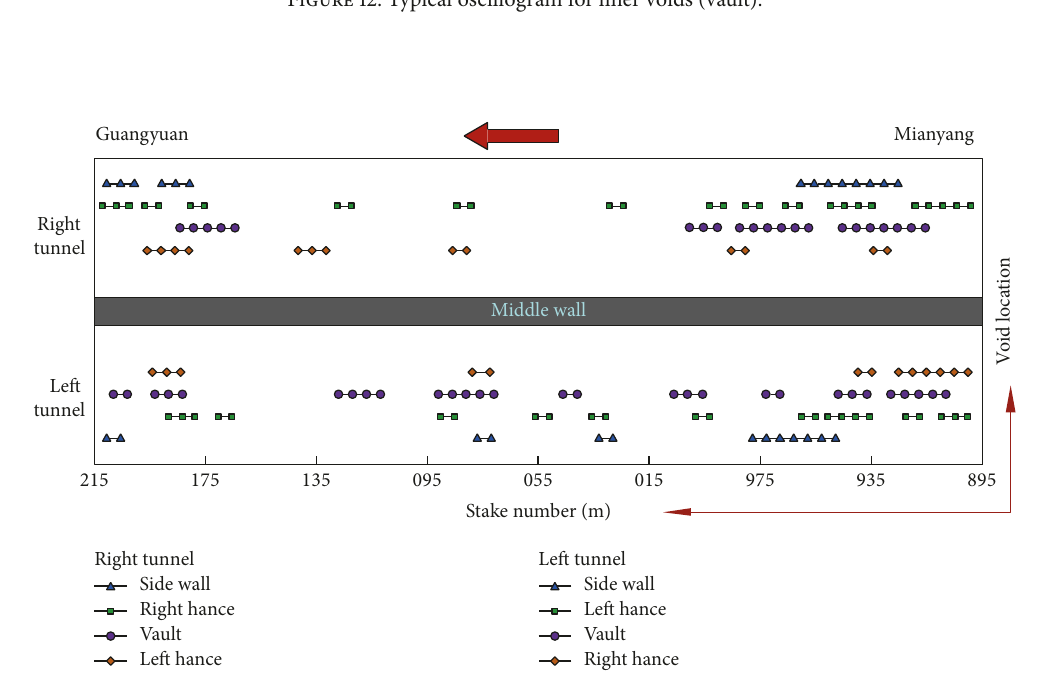
Figure 13: Void area